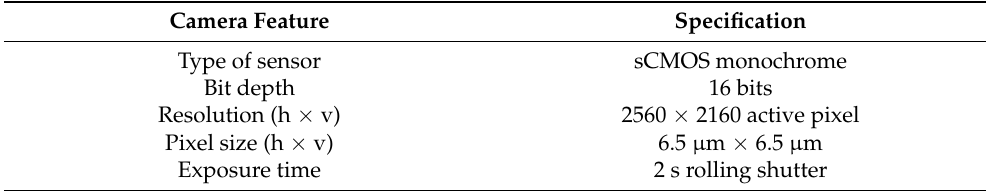
Table 1. Technical specifications of the sCMOS camera (h: horizontal, v: